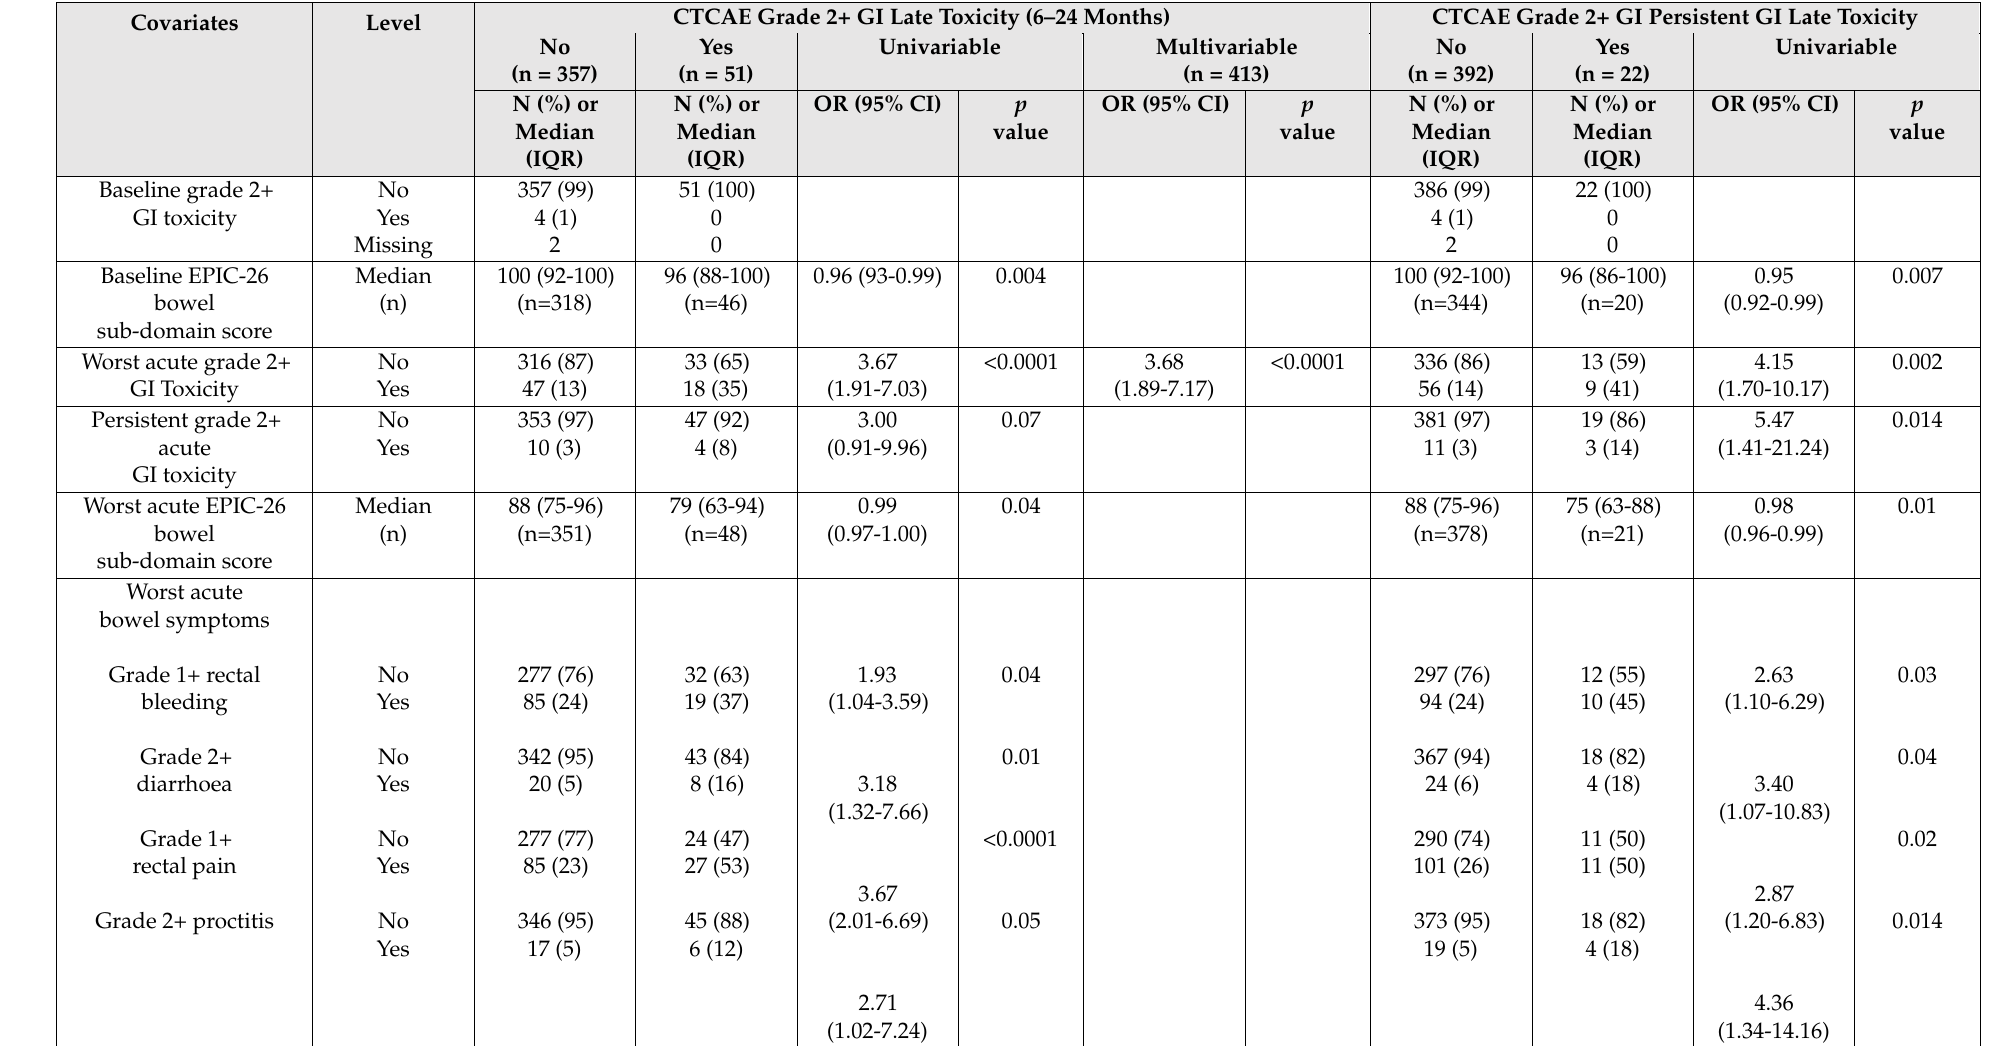
Table 4. Univariable and multivariable logistic regression model to identify covariates associated with late CTCAE gastrointestinal toxicity after